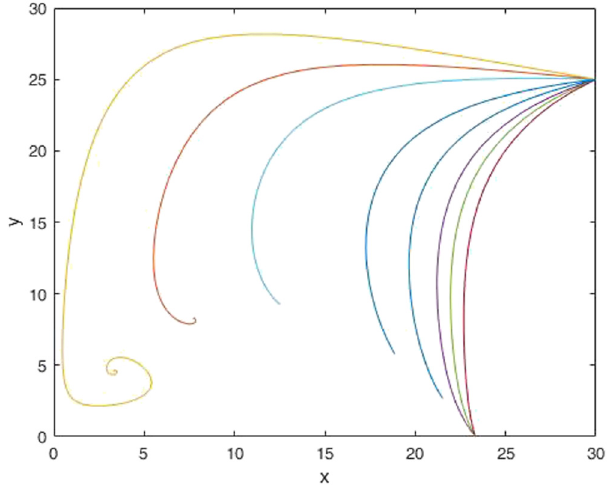
Figure 5: Stability of system ( 2.1 ) depends on b